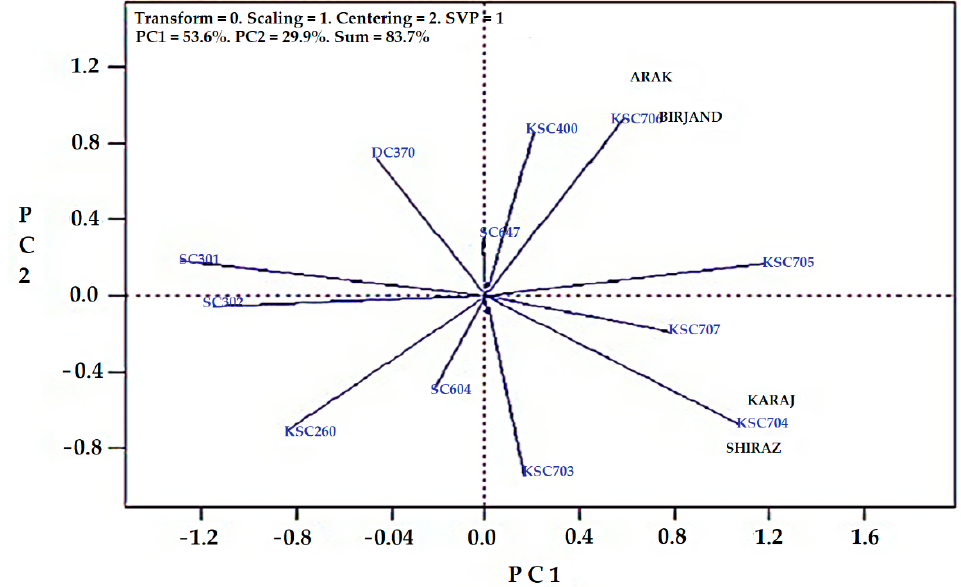
Figure 5. Biplot diagram correlation between genotypes in corn hybrids test.